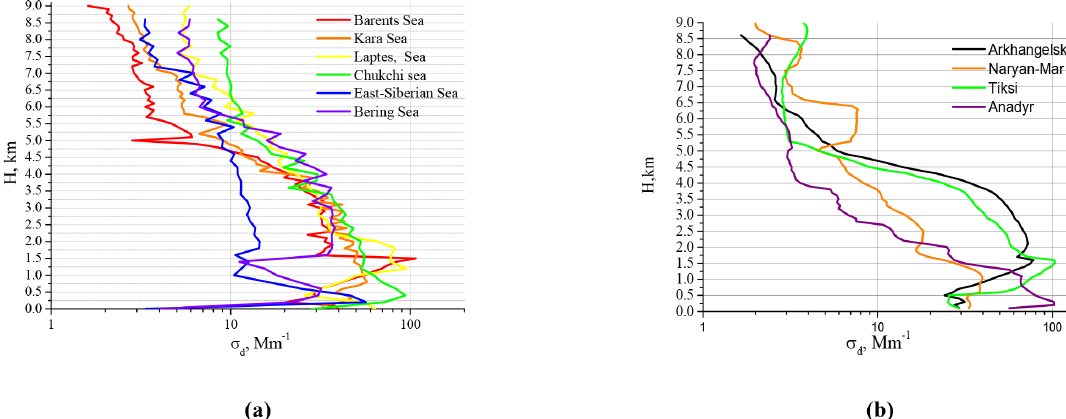
Figure 19. Vertical profiles of scattering coefficients on 4–17 September 2020: over (a) sea and (b) coastal